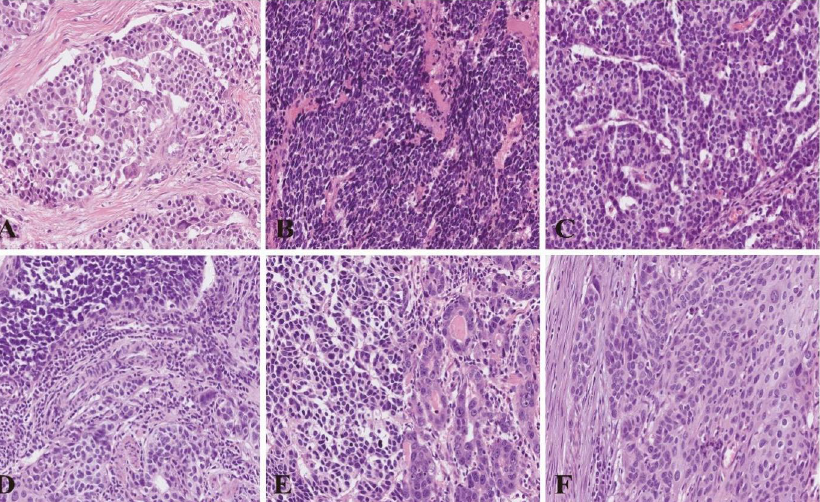
Figure 3. Cell morphology of esophageal neuroendocrine neoplasms and esophageal squamous cell carcinoma under 40 × magnification using hematoxylin and eosin staining: ( A ) neuroendocrine tumor; ( B ) small-cell neuroendocrine carcinomas (NECs); ( C ) large-cell NECs; ( D ) small-cell NECs mixed with squamous cell carcinoma; and ( E ) small-cell NECs mixed with adenocarcinoma; and ( F ) esophageal squamous cell carcinoma.